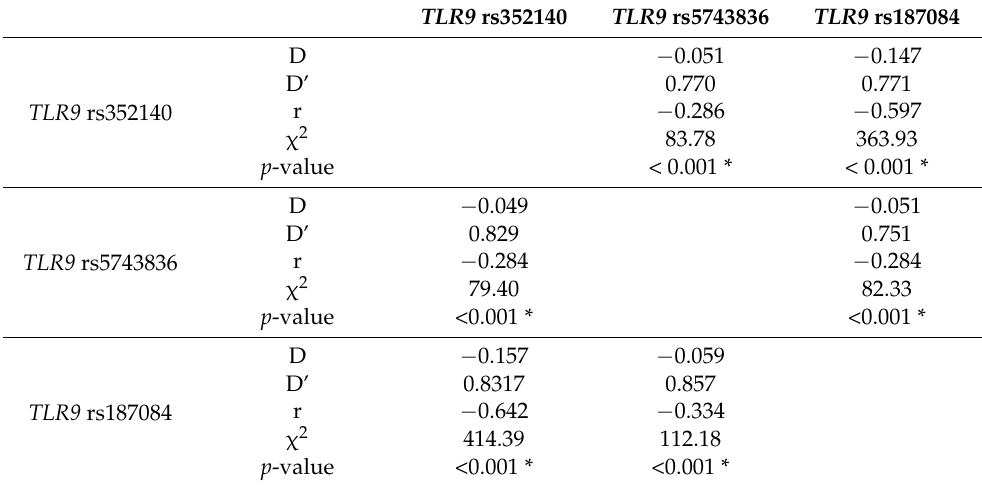
Table 3. Linkage disequilibrium analysis for TLR9 SNPs in AML patients and